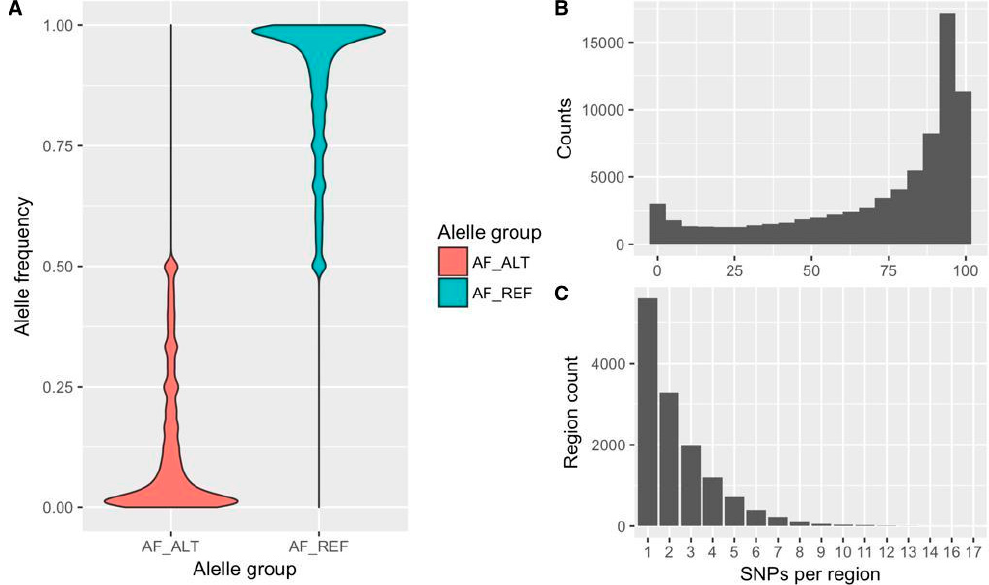
Figure 1. Initial characterization of the INTA ddRADseq matrix before filtering. ( A ) Allele frequency. AF_ALT, alternative allele (i.e., less frequent allele); AF_REF, reference allele (i.e., most frequent allele); ( B ) Percentage of missing data ( x -axis: percentage); ( C ) Number of SNPs per tag, or sequenced region (110 bp).